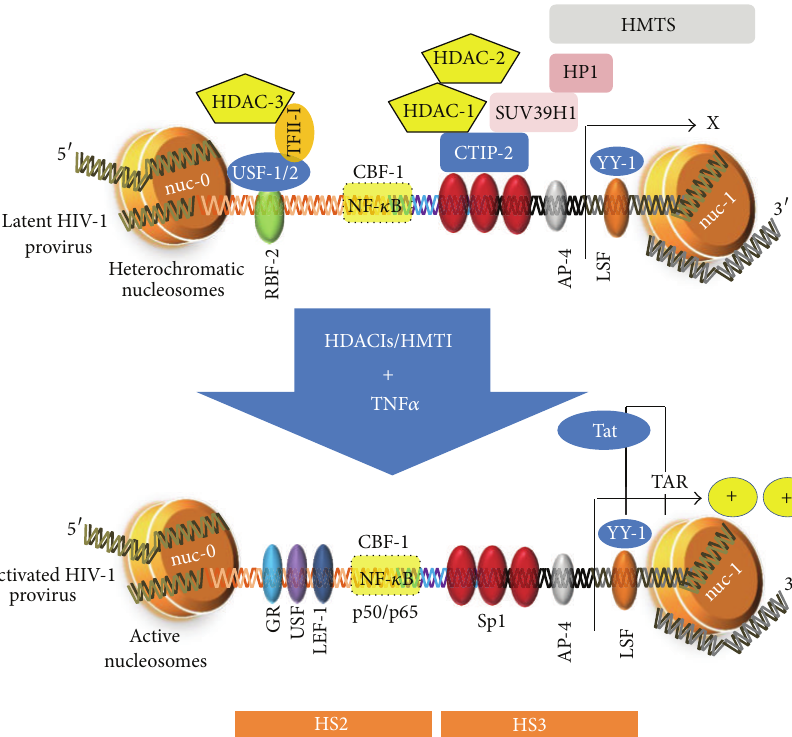
Figure 4: Potential TNF-based therapies to reactivate HIV-1 from latency. During HIV-1 latency, nuc-1 nucleosome is hypoacetylated. CTIP-2 interacts with Sp1, switching nuc-1 from transcriptionally active to a repressive state. Furthermore, CTIP-2 recruits HDACs that deacetylate the nuc-1 nucleosome. SUV39H1 adds trimethylation mark onto the histone protein H3. Furthermore, HP1 protein stabilizes the nuc-1 in transcriptionally silent state. The combination of TNF-alpha with HDACIs or HMTIs can disrupt the HIV-1 latency. TNF-alpha and HDACIs can trigger the activation of transcriptional activators, such as NF-kappaB (p50/p65 heterodimer). HDACIs may prevent the formation of heterochromatin, resulting in nuc-1 hyperacetylation and remodeling, thereby alleviating the HIV transcriptional block. The use of TNF, HDACIs,andHMTIsenhancesHIV-1LTRtranscriptionandcouldparticipateintheclearanceofHIV-1fromcellularreservoirsandultimately could lead to the cure of HIV-infected